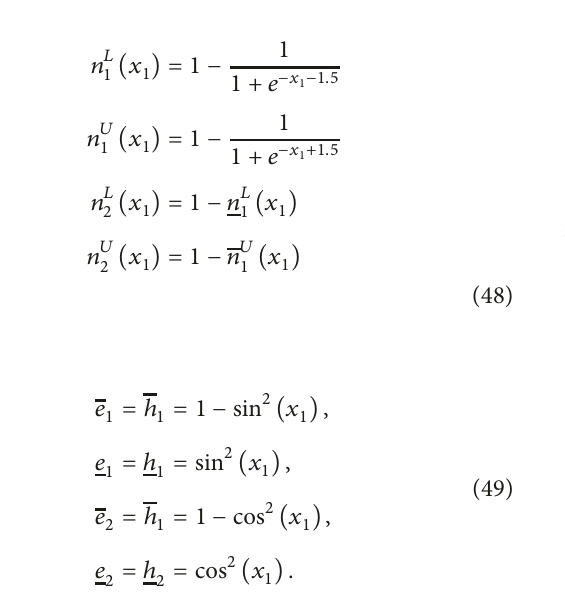
Figure 4: Release time and release interval with different the value of 𝜂 and 𝜗 max .